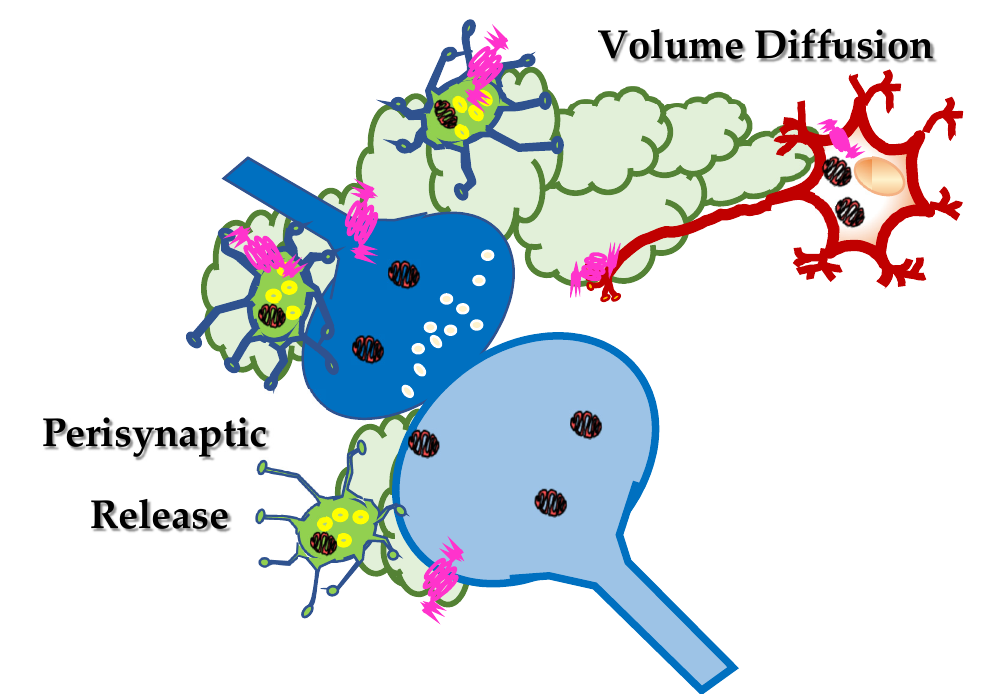
Figure 2. Somatostatin localizes in inter-neuronal networks (green neurons) and it is preferentially released, upon application of a depolarizing stimulus, perisynaptically, far from the synaptic active zone. Here, somatostatin can activate auto- and heteroreceptors located extrasynaptically, close to the synaptic active zone, that are referred to as perisynaptic receptors. Somatostatin can also diffuse in the extracellular space, throughout the mechanism of the “volume diffusion” (light green clouds), to activate distant sst receptors located on brain targets far from the site of release.